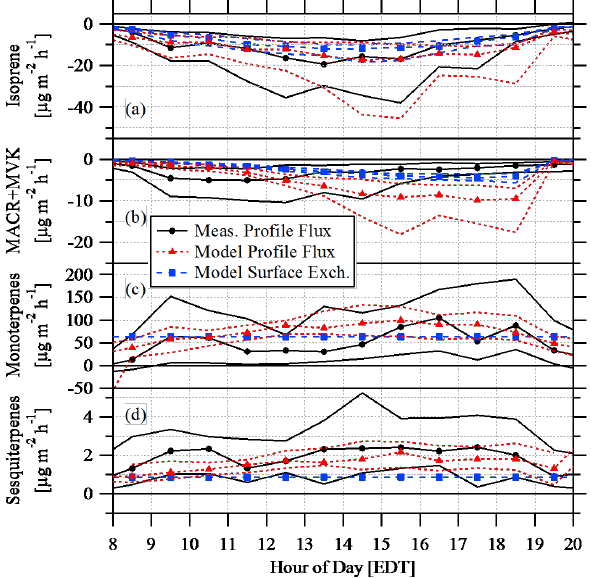
Figure 4. Hourly medians and quartiles of fluxes [µgm − 2 h − 1 ] as determined from the profile method and compared to the mod- elled surface exchange fluxes (blue squares). The profile method is used to estimate surface fluxes with both the measurements (black circles) and the model results (red triangles) between 1 and 6m